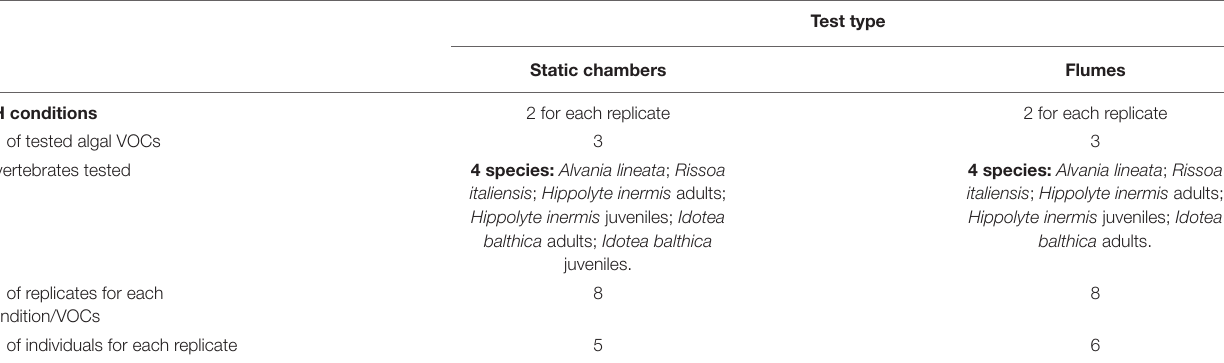
TABLE 1 | Experimental plan of behavioral tests for the three algae and four species considered. The number of replicates, treatments, and pH levels are shown in the table.